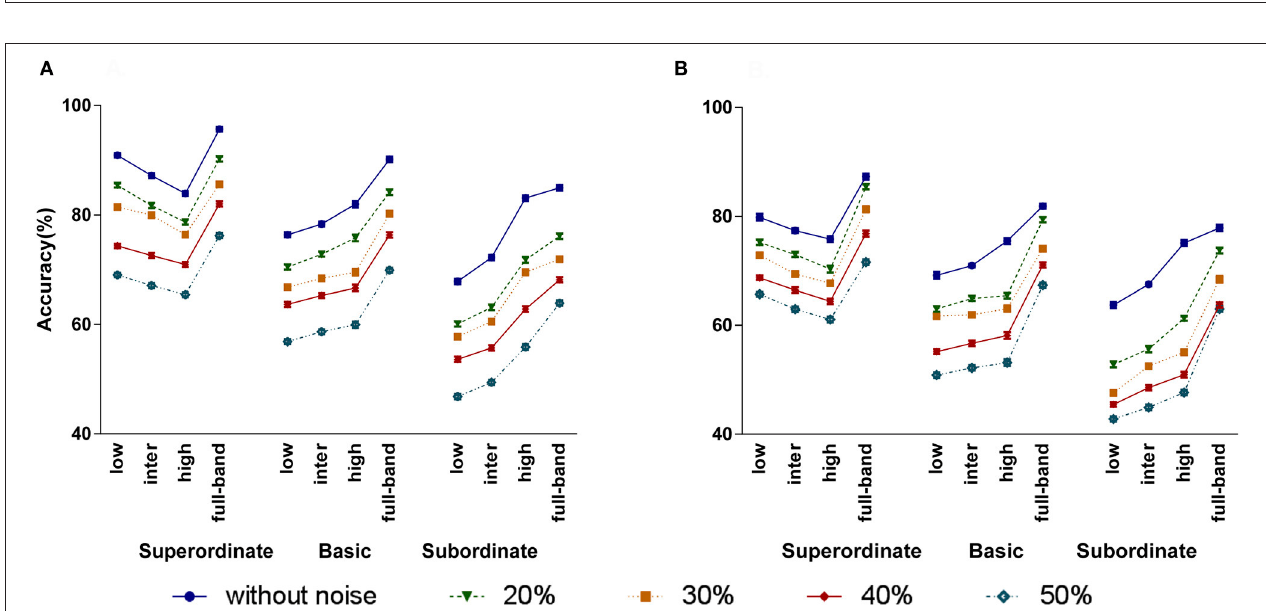
FIGURE 9 | The effect of adding different amounts of noise to the image stimuli (20, 30, 40, and 50%) on the accuracy of Model I (A) and Model II (B) . Error bars represent standard error of the mean (SEM). The between (within) group df is 59 (540).